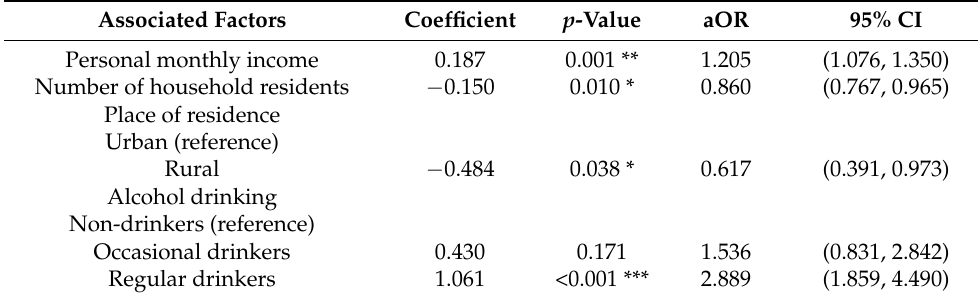
Table 2. Associated factors of prolonged screen time.